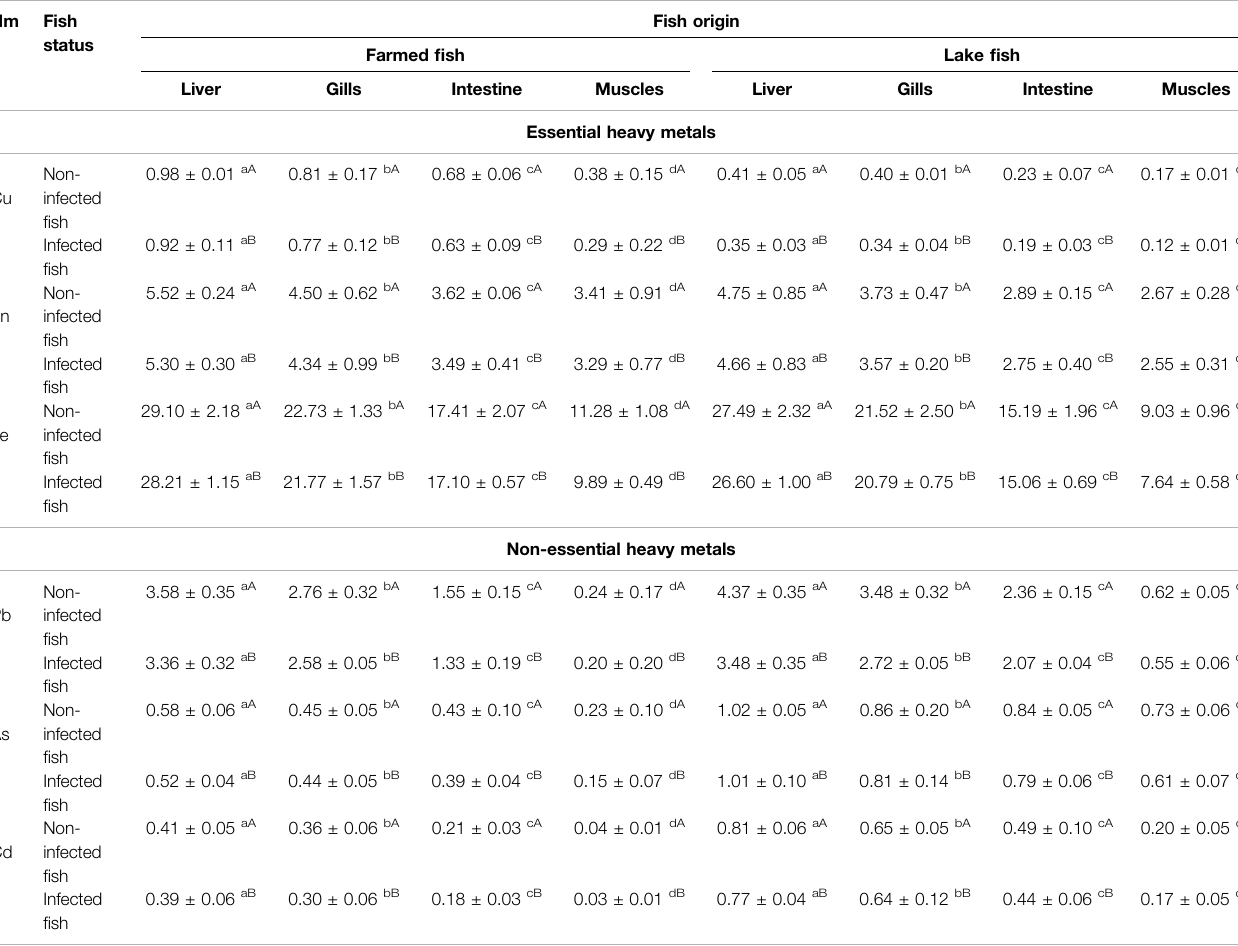
TABLE 7| Heavy metal concentrationsindifferentorgans oflakeand farmed O.niloticus .Differentsuperscript letters inthesamecolumnand metalare signi fi cantlydifferent (T-test, p < 0.05). While results from the same row and origin with different alphabetic letters are statistically different (ANOVA, p < 0.05). Hm Fish